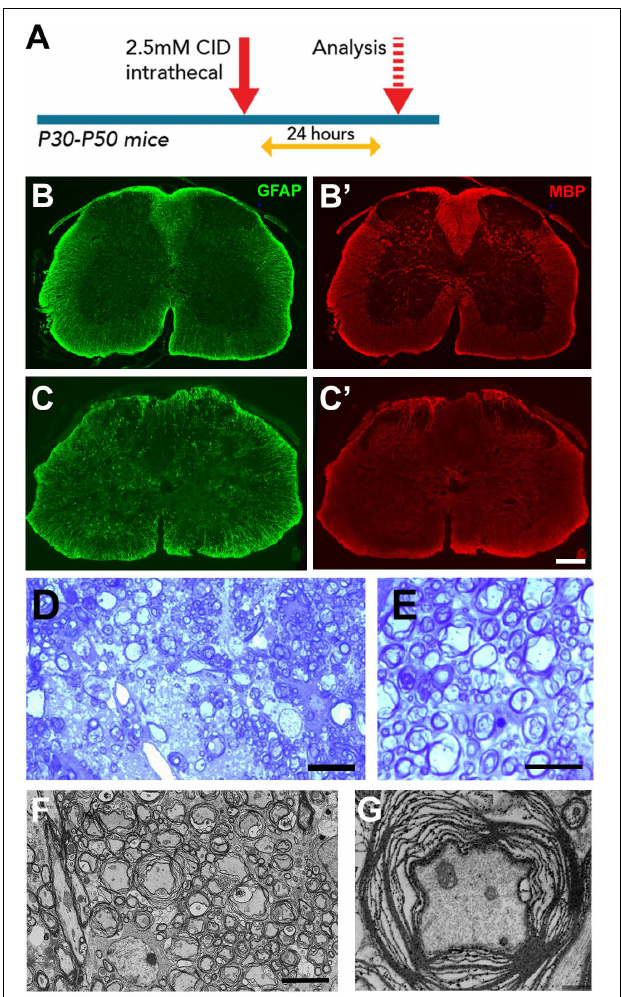
FIGURE 5 | Astrocyte loss in vivo resulted in local disruption of myelin integrity. (A) Experimental design. (B,C) Compared to control segments (B,B’) , CID treated segments of GFAP-iCP9 animals had a reduction in GFAP+ cells (C) and reduction in MBP expression (C’) . (D,E) Representative toluidine blue stained images of 1 µ m spinal cord sections from adult GFAP-iCP9 mice after intrathecal injection of CID. Local astrocyte loss resulted in loss of myelin (D) and myelin decompaction (E) . (F,G) Ultrastructural analysis confirms loss of myelin integrity while axons remain morphologically relatively normal (G) . Scale Bars: (D) 20 µ m; (E) 5 µ m; (F) 5 µ m; (G) 1 µ m; (B,C) 200 µ m.